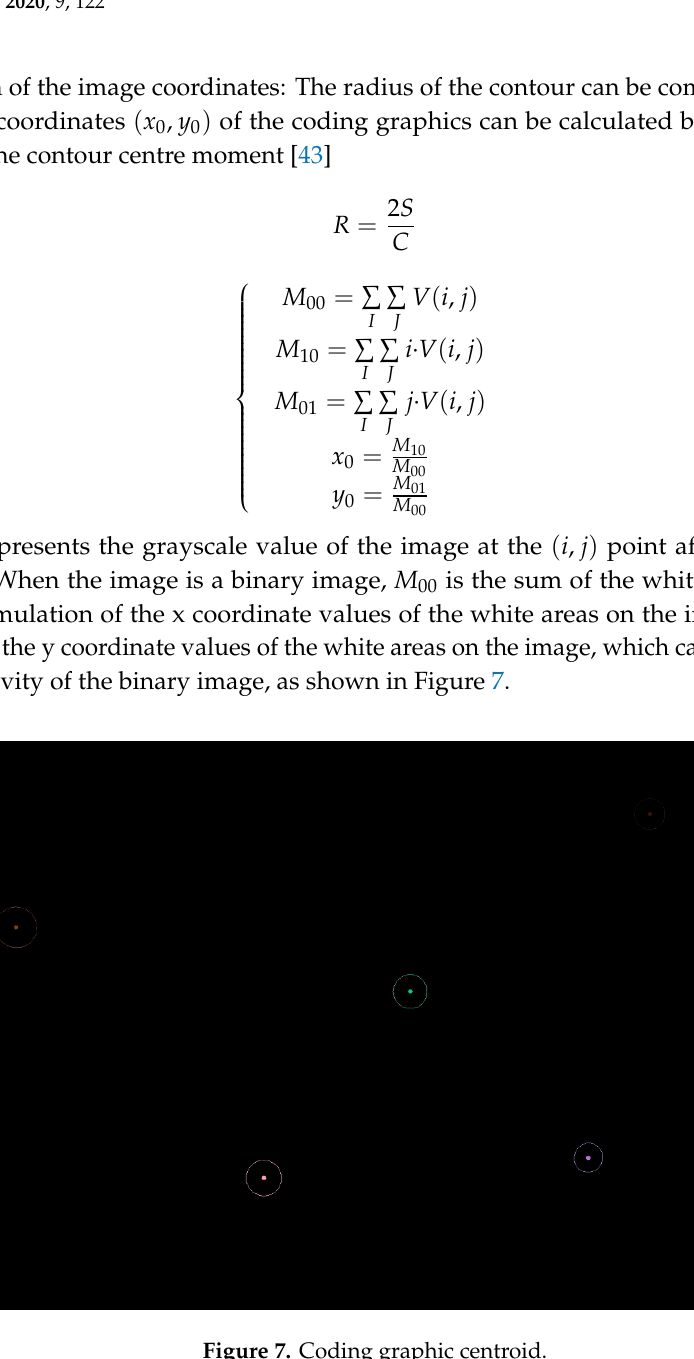
Figure 7. Coding graphic centroid.